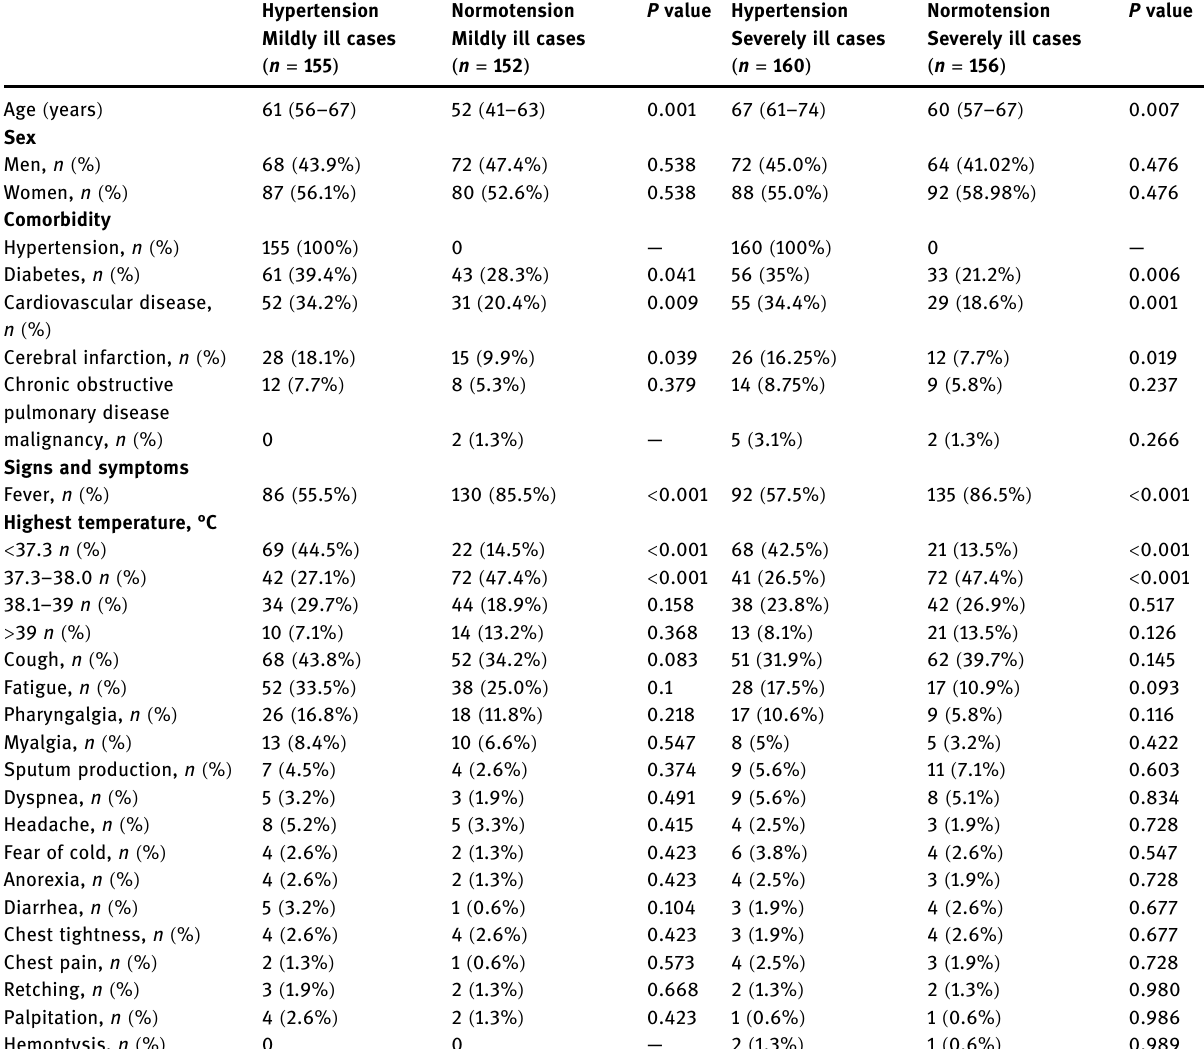
Table 1: Comparison of characteristics and symptoms between the hypertensive and nonhypertensive groups infected with COVID -